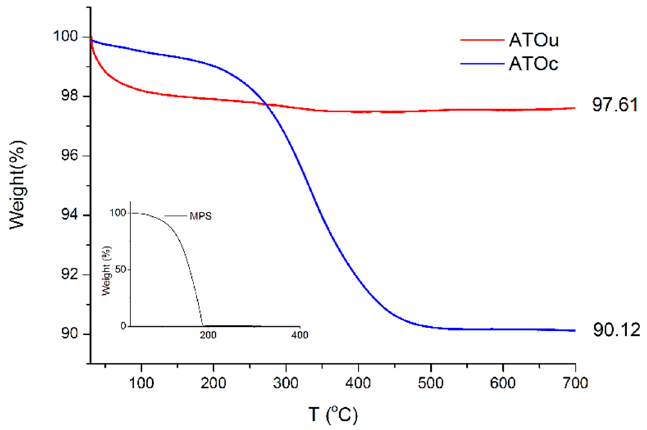
Figure 2. Thermogravimetric analysis (TGA) thermograms of bare antimony-doped tin oxide (ATOu) (red line) and surface modified ATO (ATOc) (blue line). In the inset, the TGA thermogram of pure 3 ‐ methacryloxypropyltrimethoxysilane (MPS) is shown for comparison.